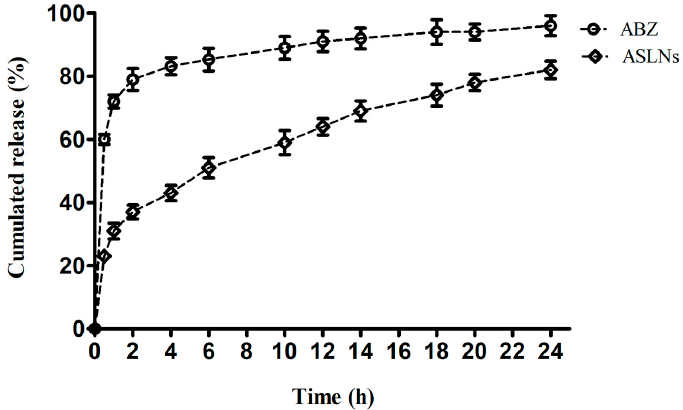
Figure 4. In vitro drug release profile of ASLNs in PBS (pH 7.4) containing 1% tween 80.